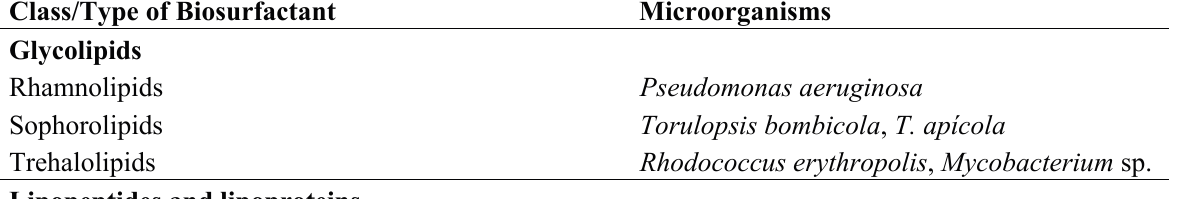
Table 3. Main classes of biosurfactants and respective producer